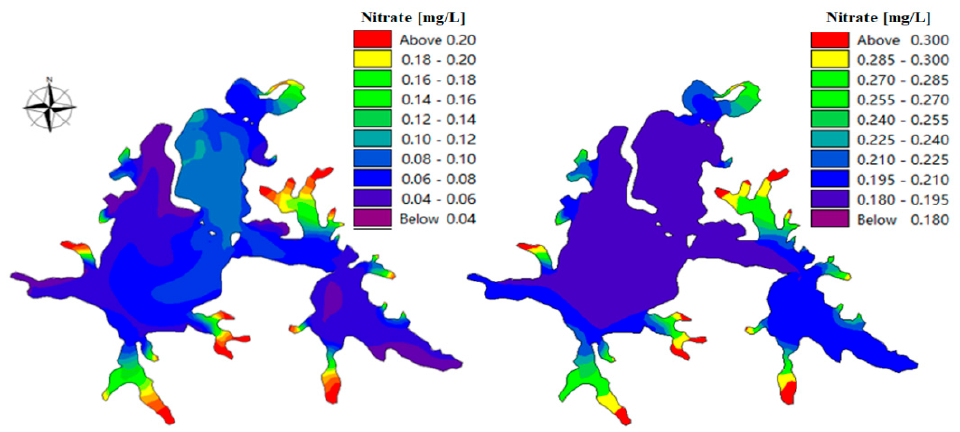
Figure 14. Comparison of nitrate simulation results based ( left ) and not based ( right ) on remote sensing optimization.